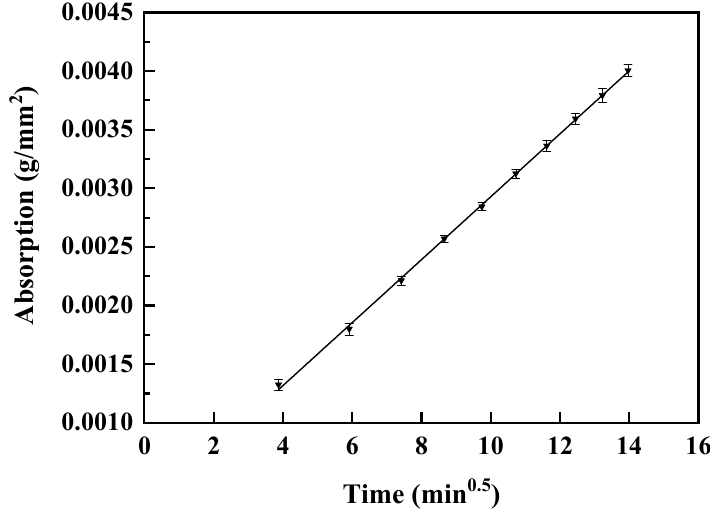
Figure 8. Capillary absorption vs . time.